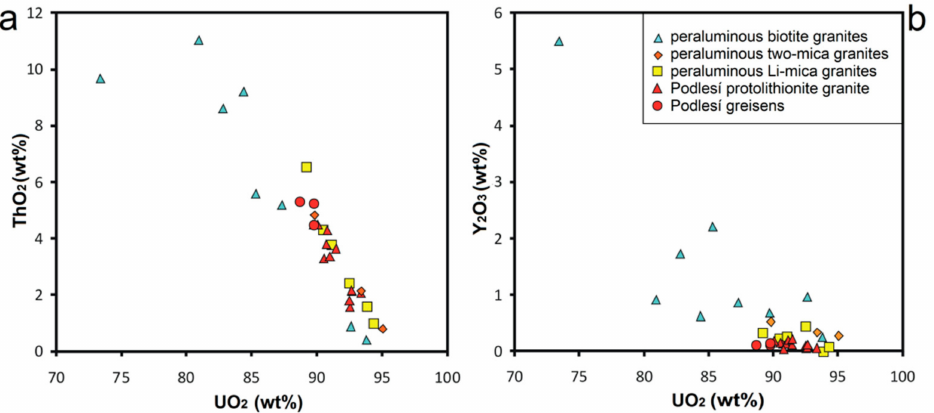
Figure 7. Chemical composition of uraninite. ( a ) UO 2 vs. ThO 2 ; ( b ) UO 2 vs. Y 2 O 3